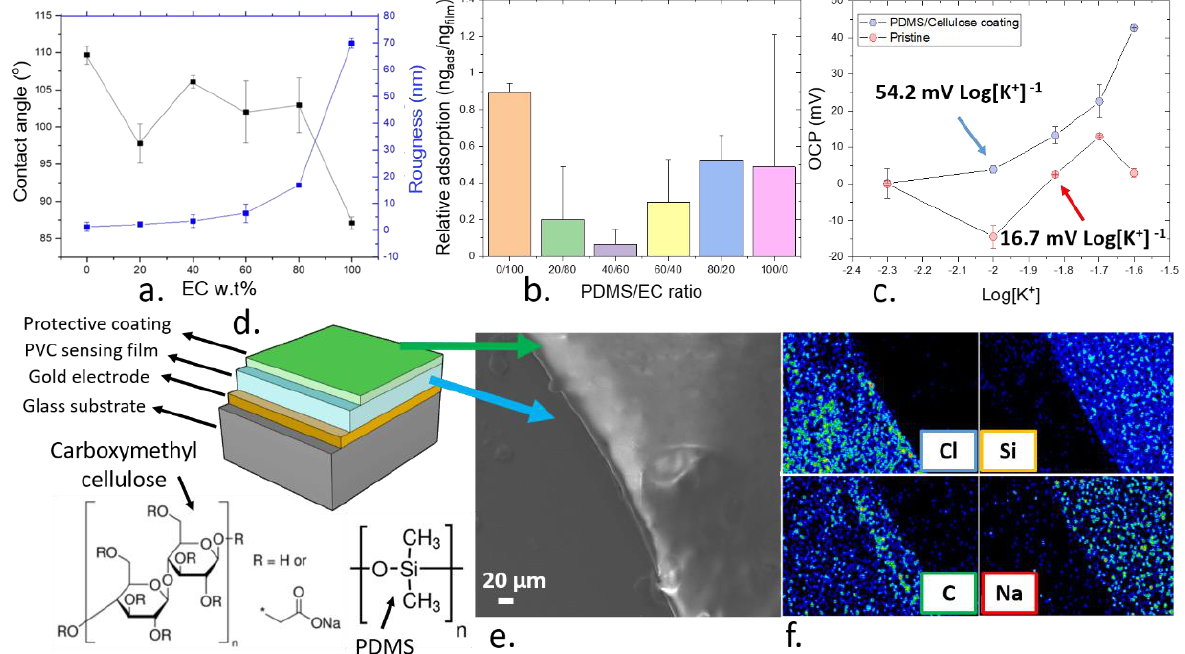
Figure 5. ( a ). Relationship between the water contact angle and the roughness of the poly(dimethyl) siloxane (PDMS)/ethyl cellulose (EC) films at different compositions of EC. ( b ). Characterization of protein adsorption of the ion films by quartz microbalance when using a solution containing 40 mg mL − 1 albumin on the PVC films coated with different PDMS/EC protective layers. ( c ). Sensitivity of the pristine (red) and coated (blue) ion sensors after 5 weeks of continuous measurement in the presence of 0.1 M KCl. ( d ). Schematic representation of the ion sensors containing a substrate, contact electrode, PVC sensing film and protective coating. ( e ). SEM imaging of the PVC sensing film (left) and the PDMS/EC protective coating (right). ( f ). EDS elemental mapping of both the plasticized PVC film and the PDMS/EC protective coating, confirming the composition of the films.